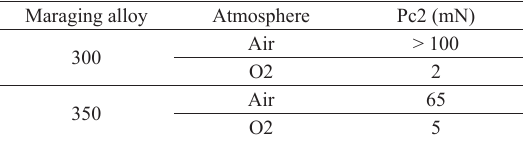
Table 9. Pc2 directly determined from the FE-SEM micrographs for the oxide produced by each condition. Maraging alloy